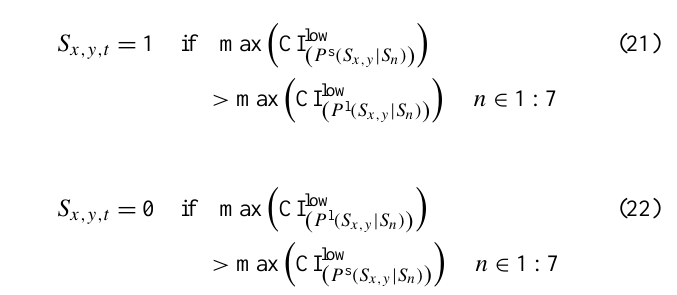
to be decisive for